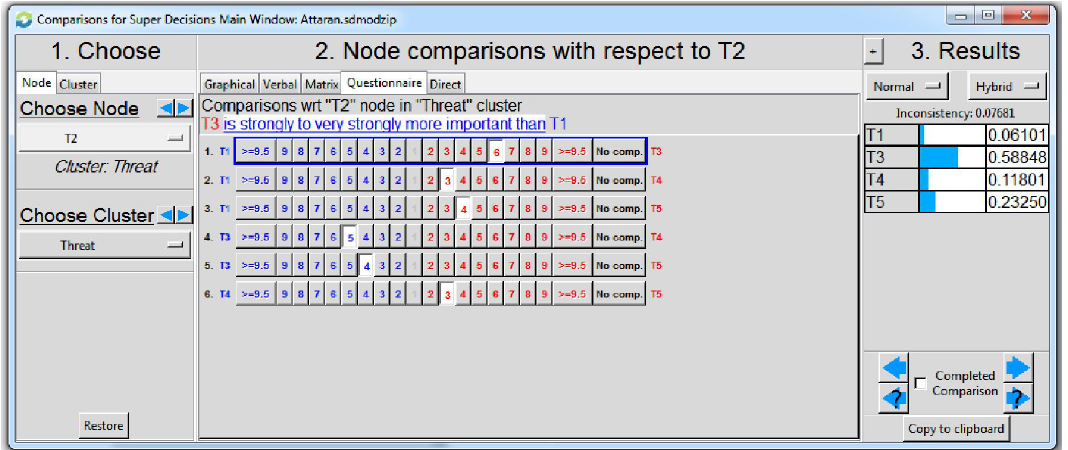
Fig. 5. Input/output of factors associated with